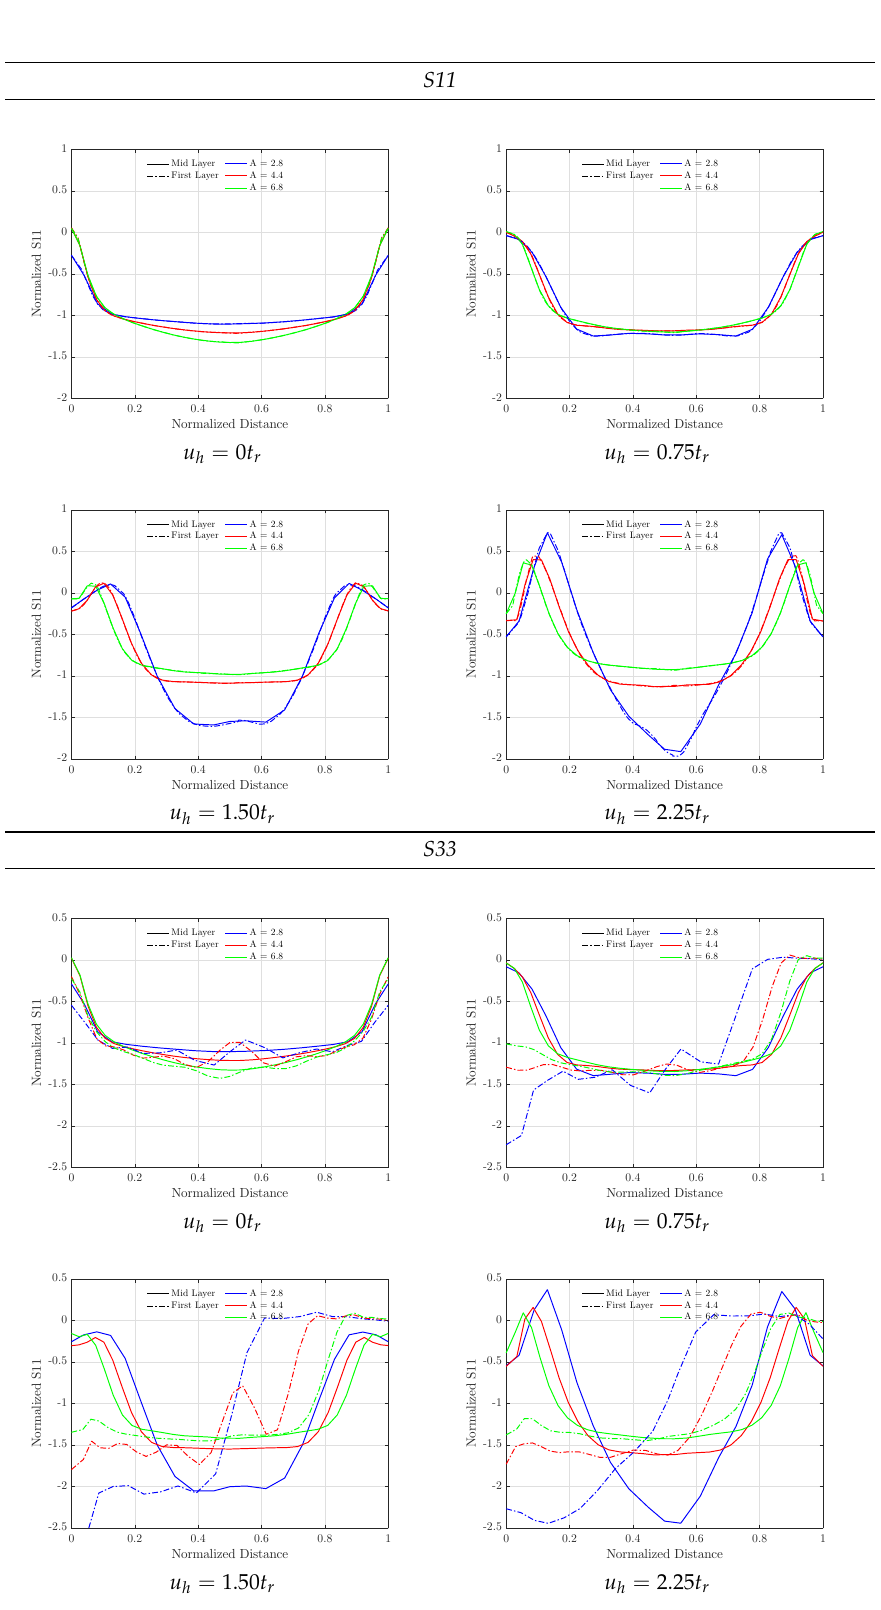
Figure 14. Axial normal stress S11 and vertical normal stress S33 along the symmetry axis. Effect of aspect ratio A